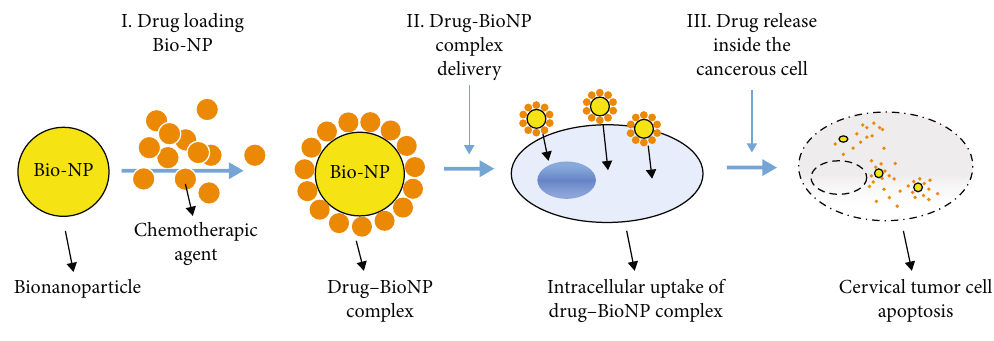
Figure 2: Systemic drug delivery system in cervical cancer; Bio-NP: